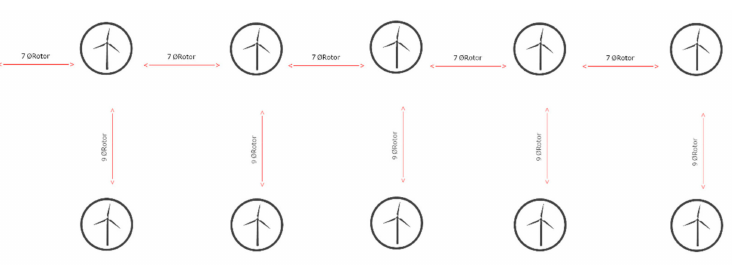
Figure 7. Structure of a wind farm. Source: own